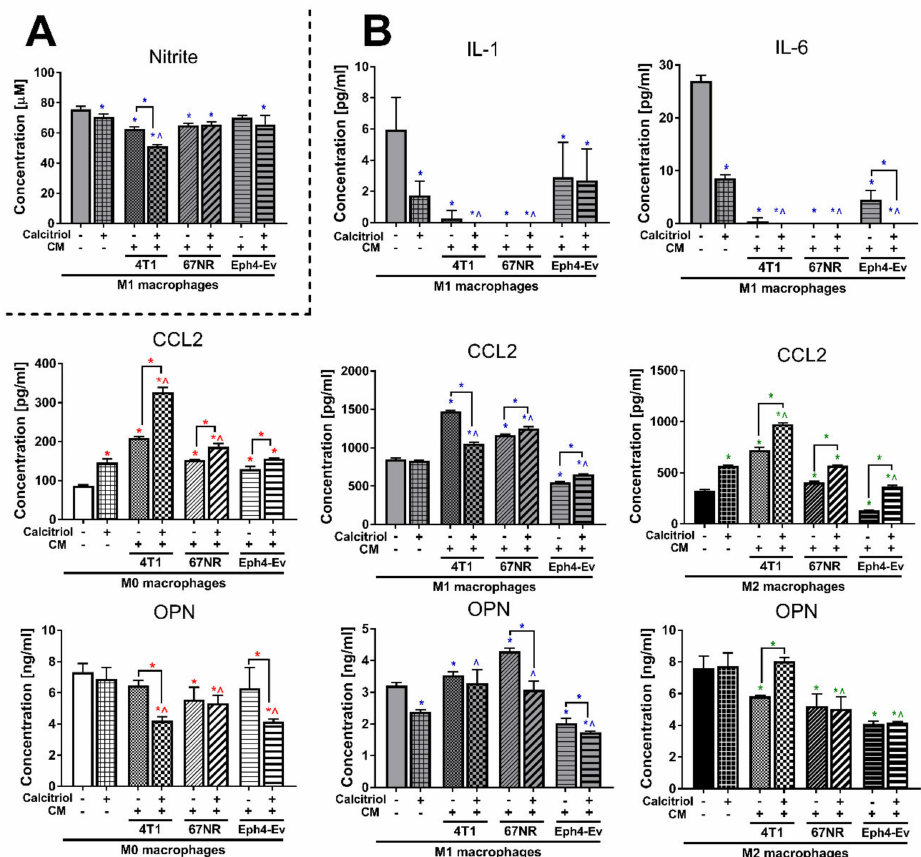
Figure 7. Determination of the e ff ect of CM and calcitriol on the level of expression of markers describing individual BMDMs classes: ( A ) nitrite ion measurement by Griess assay and ( B ) measurement of IL-1, IL-6, CCL2, and OPN concentrations by ELISA. 4T1 CM +/ - calcitriol decreased the concentration of nitrite, IL-1, IL-6, and CCL2 ions for M1 BMDMs and increased the concentration of CCL2 for M0 and M2 BMDMs and OPN for M2 BMDMs. ELISA assays and measurement of arginase activity and nitrite ions concentration (Griess assay) were performed according to the manufacturers’ protocols. Data presentation: mean with standard deviation. Number of independent repetitions = 3 ( B ) or 4 ( A ) (BMDM cultures generated from three or four mice). Statistical analysis: Sidak’s or Dunn’s multiple comparisons test. * (red) p < 0.05 as compared to M0 or * (blue) p < 0.05 to M1 or * (green) p < 0.05 to M2 not treated with cal and any CM, ˆ (red) p < 0.05 as compared to M0 + cal or ˆ (blue) p < 0.05 to M1 + cal or ˆ (green) p < 0.05 to M2 + cal not treated with any CM; or as